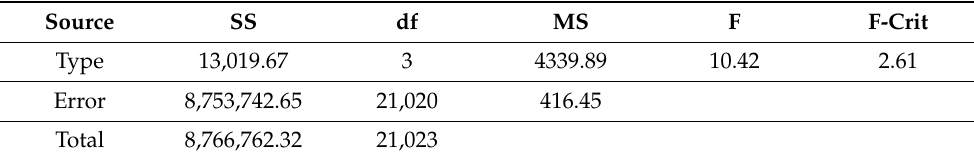
Table 3. One-way analysis of variance on forecasting results based on the historical data of PM2.5 in different regions as the input data of the network. In this table, SS is the sum of squares and df is the degrees of freedom. The MS (mean squares) is the estimate of variance given by SS/df.